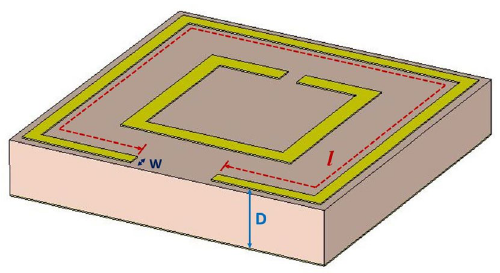
Figure 2. Microstrip resonator in the MM unit cell patch.